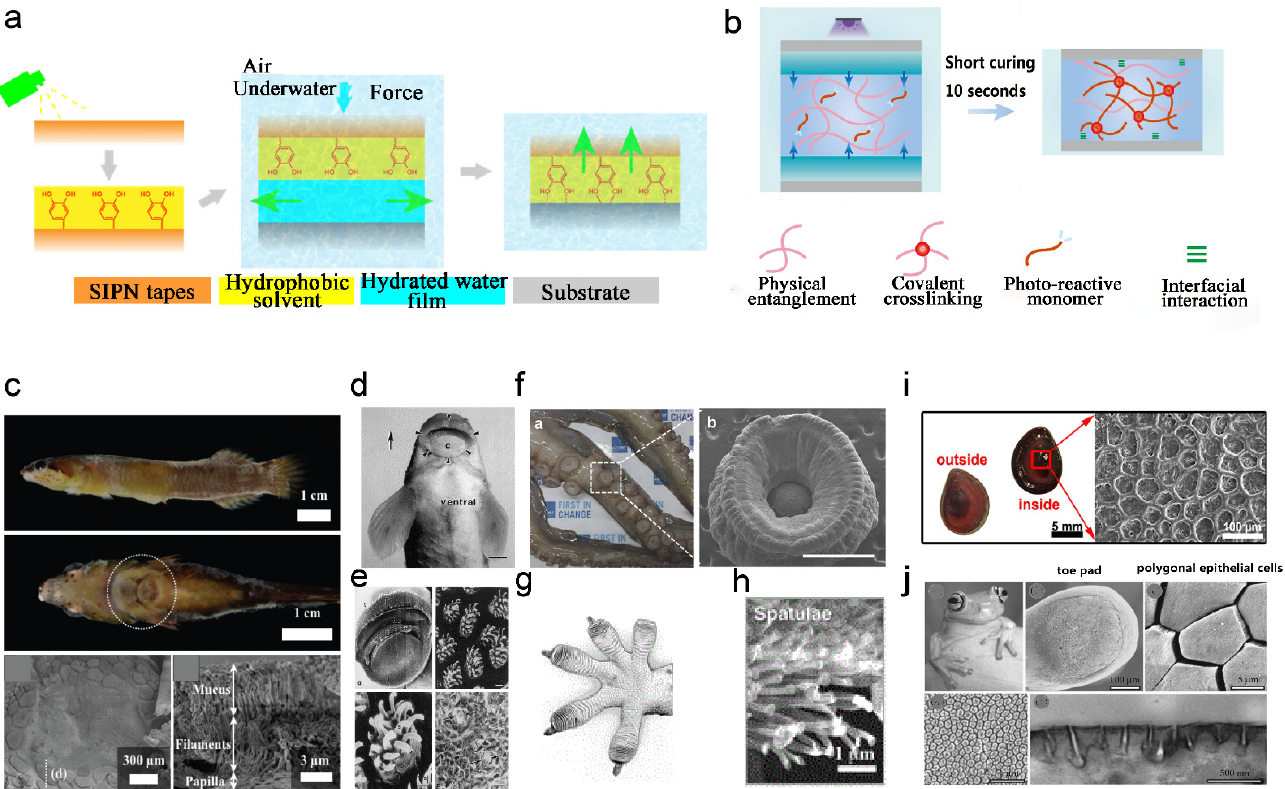
Figure 5. ( a ) Exclusion of interfacial water to enhance adhesion strategy. Figure modified from [58] with permission. ( b ) Absorption of interfacial water and rapid light curing strategies. Figure modified from [62] with permission. ( c ) Clingfish photos and SEM images of adherent disc surface morphology. Reprinted (adapted) with permission from [80]. Copyright {2022} American Chemical Society. ( d ) Teleost photographs and ( e ) SEM images of mouth surface morphology. Figure modified from [81] with permission. ( f ) Photographs of octopus tentacles and SEM images of its suckers (scale bar: 1 mm). Figure modified from [82] with permission. ( g ) Ventral diagram of the gecko foot. ( h ) SEM diagram of foot setae morphology. Figure modified from [83] with permission. ( i ) Photographs of the gill cover of the snail and SEM images of the surface morphology. Re- printed (adapted) with permission from Photographs of tree frogs and SEM and TEM images of the surface morphology. Figure modified from [85] with permission. Table 1. Influencing factors of wet surface adhesion.